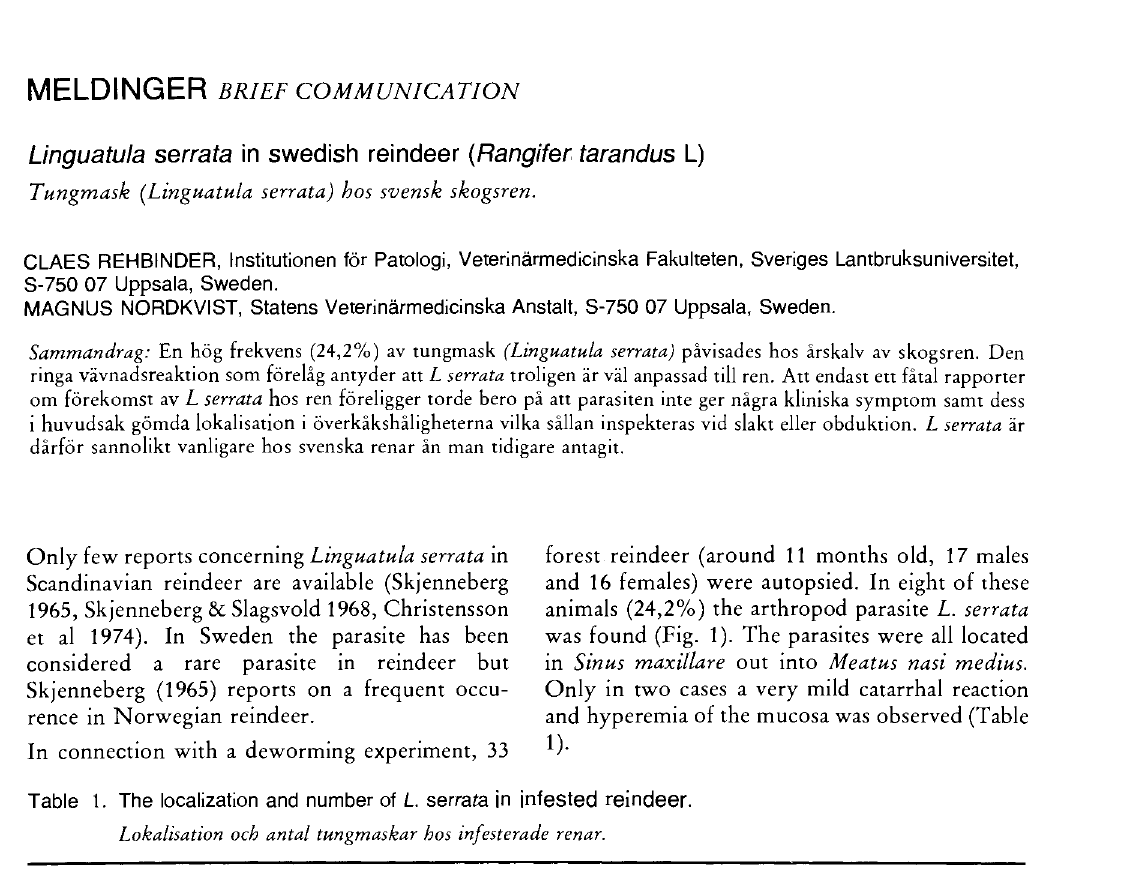
Table 1. The localization and number of L. serrata in infested reindeer. Lokalisation och antal tungmaskar hos infesterade renar. Right sinus maxillaris Catarrhal No of parasites No of parasites reaction Vänster överkäkshdla Höger överkäkshdla Katarrai Antal parasiter Antal